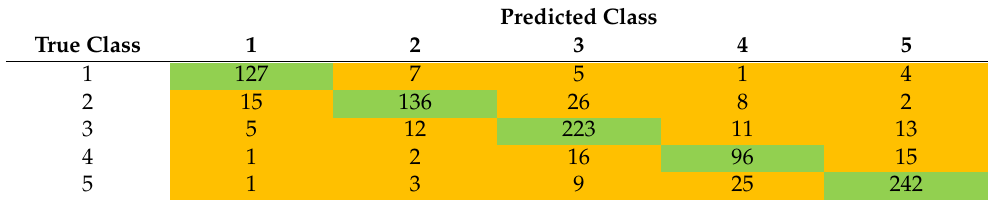
Figure 11. Accuracy of harmonic level classifiers at WF4 for different metering scenarios: ( a ) test set, ( b ) entire dataset. Table 9. Truth Table of 11th harmonic current classifier for WF4 with three harmonic meters.